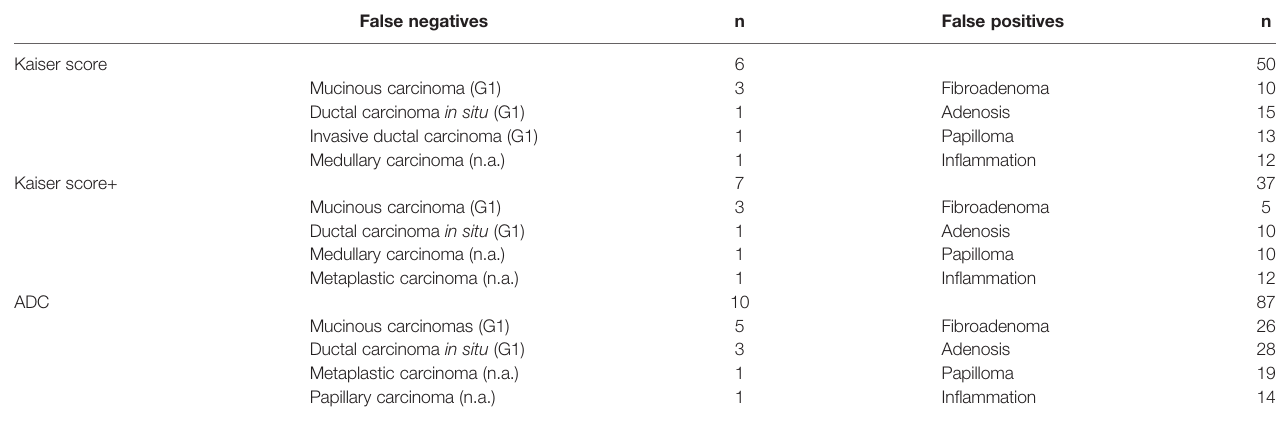
TABLE 6 | Detailed information of the false-negative and false-positive lesions diagnosed by Kaiser score, Kaiser score+, and ADC value.